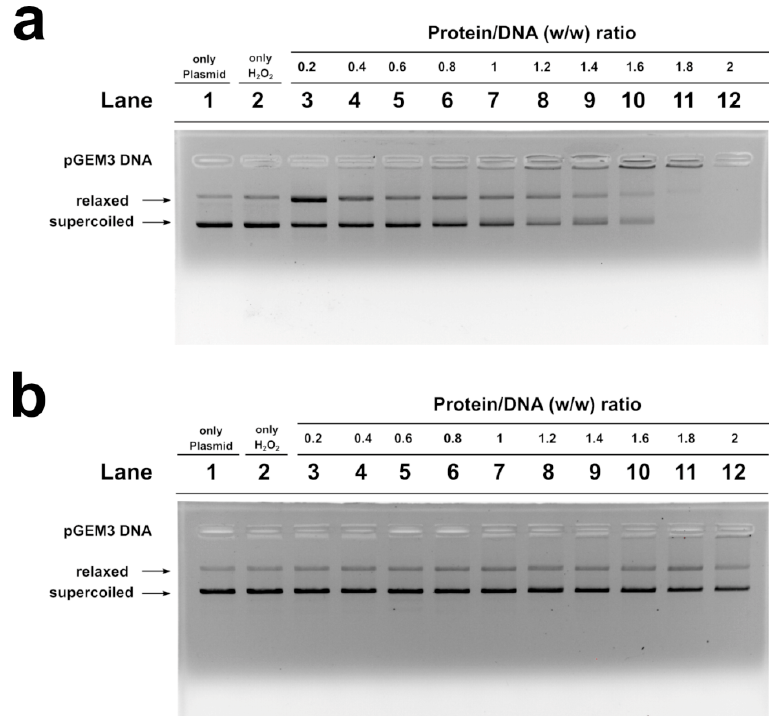
Figure 5. Analysis on 1% agarose gel of pGEM3 plamid DNA breakage induced by H 2 O 2 . In the presence of SNBP of the son ( a ) and father ( b ). SNBP: sperm nuclear basic proteins.